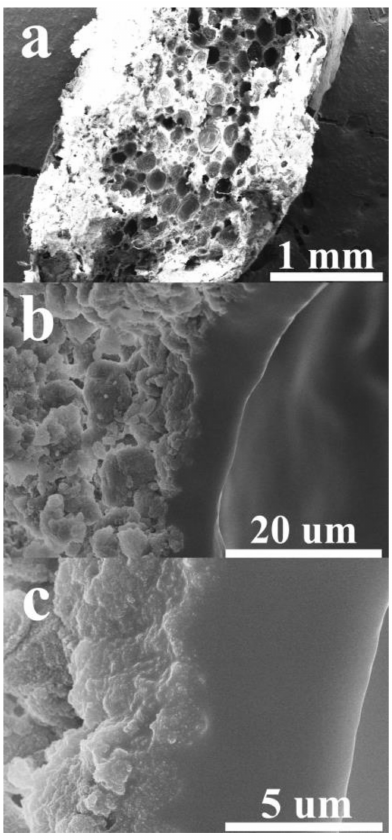
Figure 3. Cross-section FESEM micrographs of silica aerogel/NR composites with different magnifi- cations as ( a ) × 35, ( b ) × 2.5 K, and ( c ) × 10